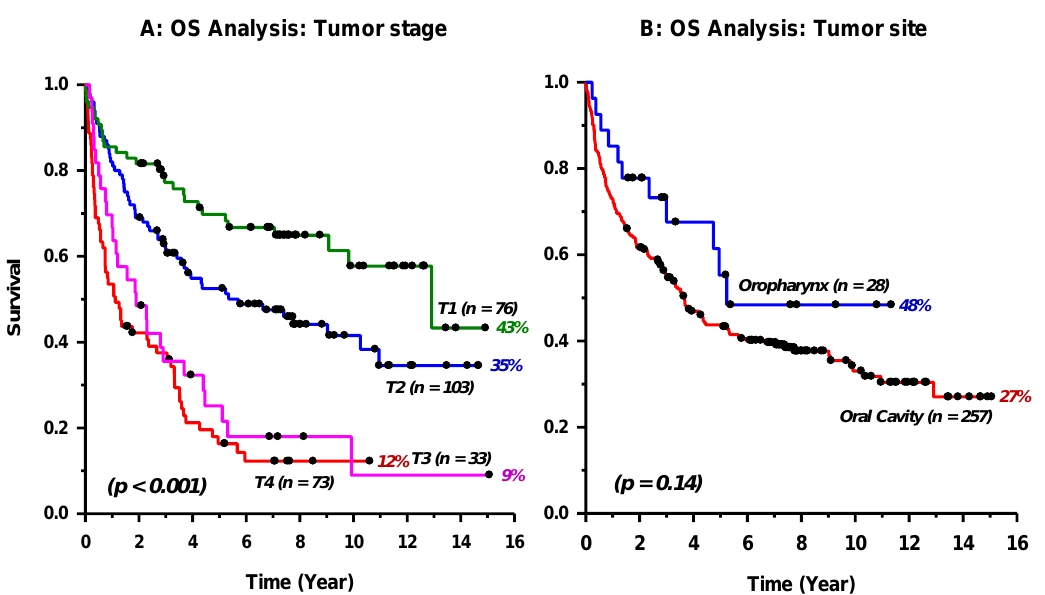
Figure 3. Kaplan – Meier Log-Rank overall survival (OS) analysis by tumor stage ( A ) and anatomical tumor site ( B ) of 285 patients with head and neck squamous cell carcinomas. The p -value in ( A ) represents the overall significance level. Al pairwise comparisons were statistically significant ( p ≤ 0.03) except T4 vs. T3 ( p = 0.32).